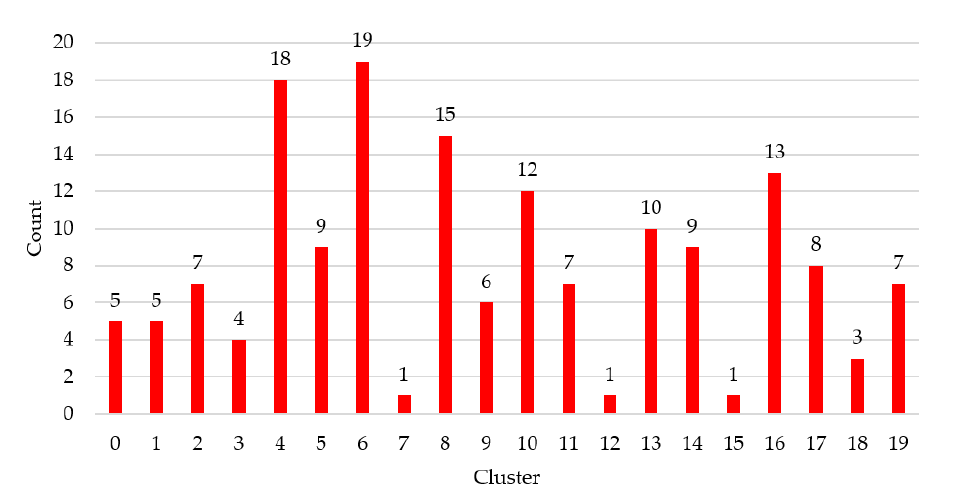
Figure 2. Number of countries per